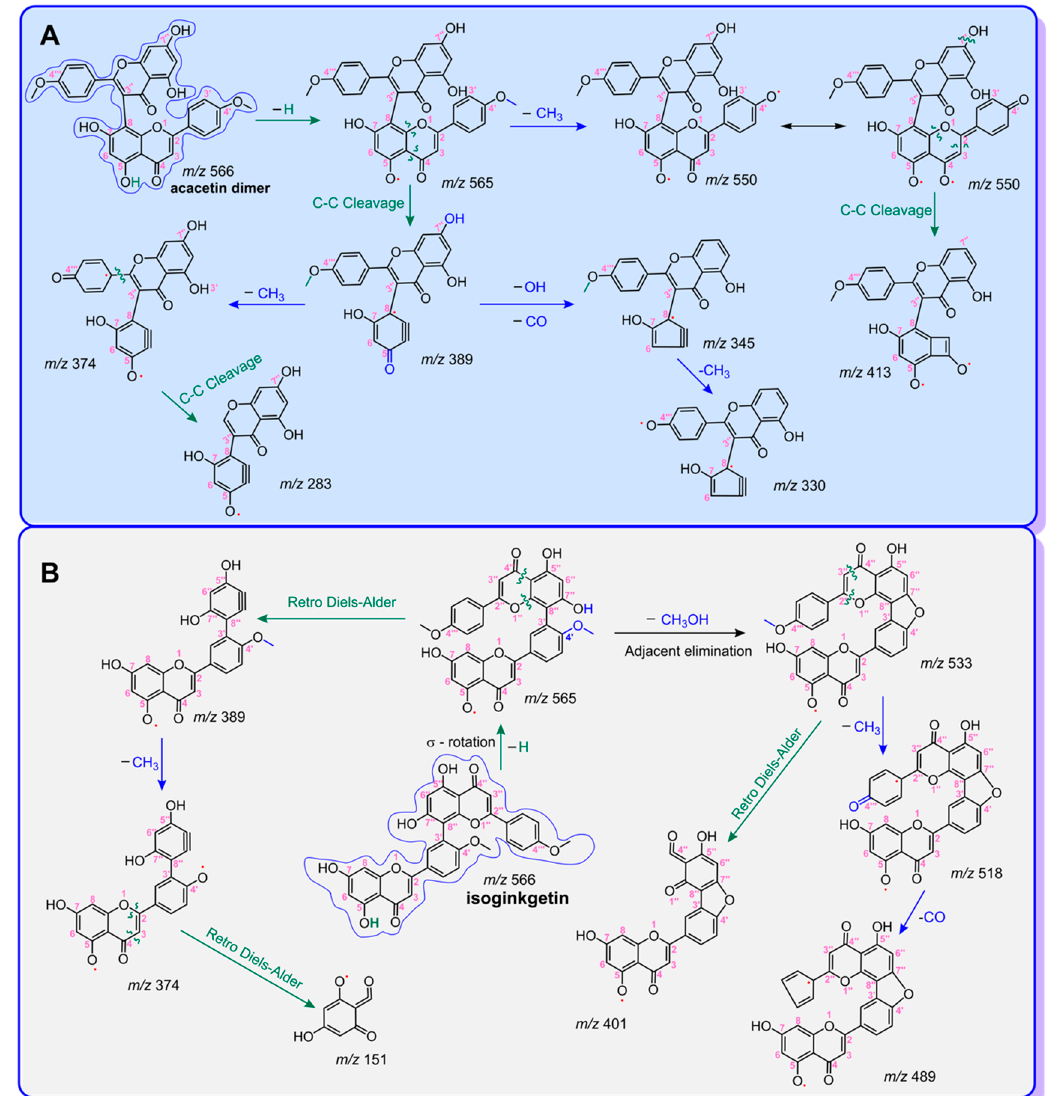
Figure 3. Proposed MS elucidation of acacetin dimer ( A ) and isoginkgetin ( B ).